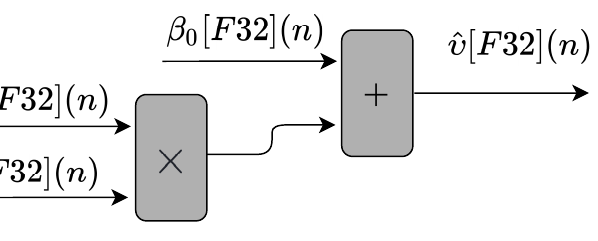
Figure 5. Block diagram representing the circuits implemented in hardware to perform the linear regression prediction technique, described in Equation (1).